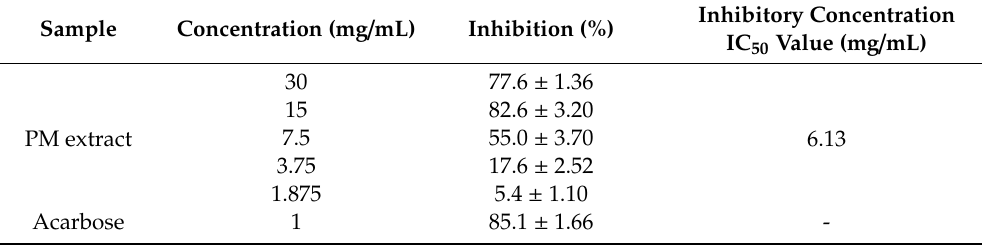
Data are presented as medians ± standard deviations (n = 3).